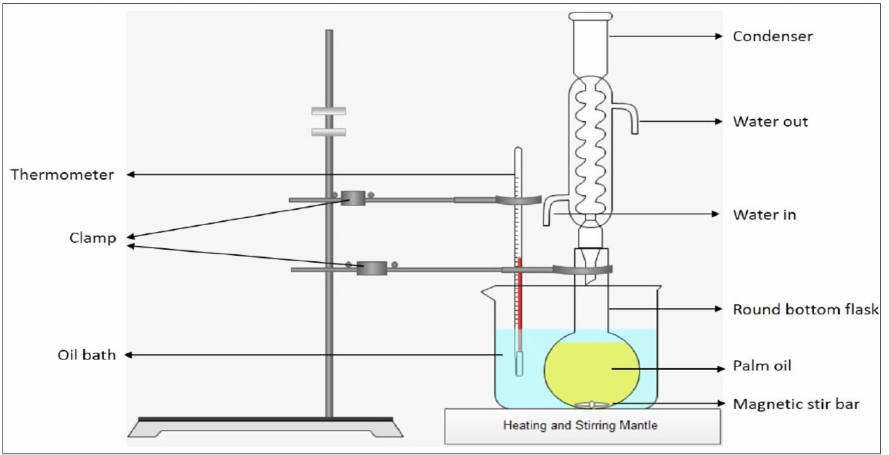
Figure 6. Transesterification method